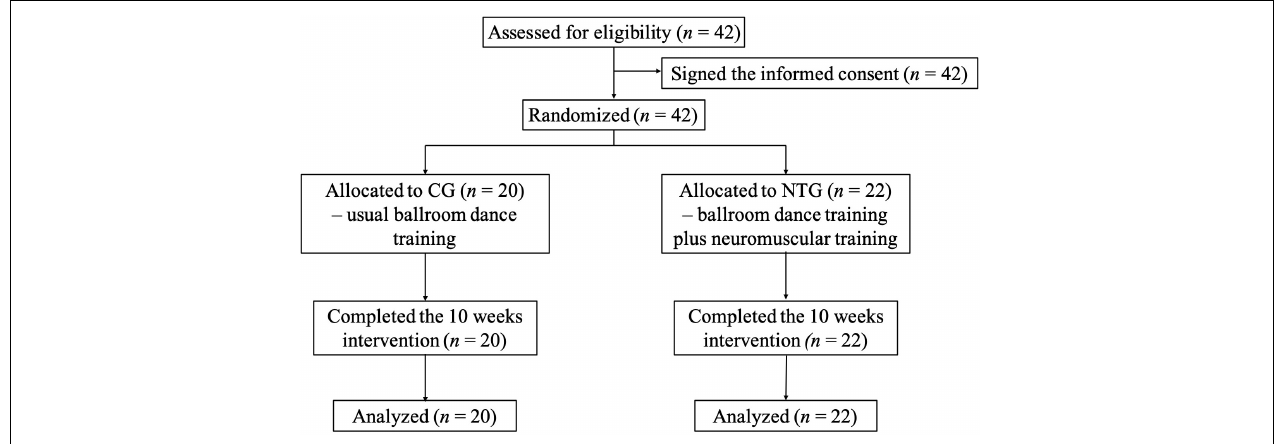
FIGURE 1 | Study flow diagram (NMT = neuromuscular training group; CG = control